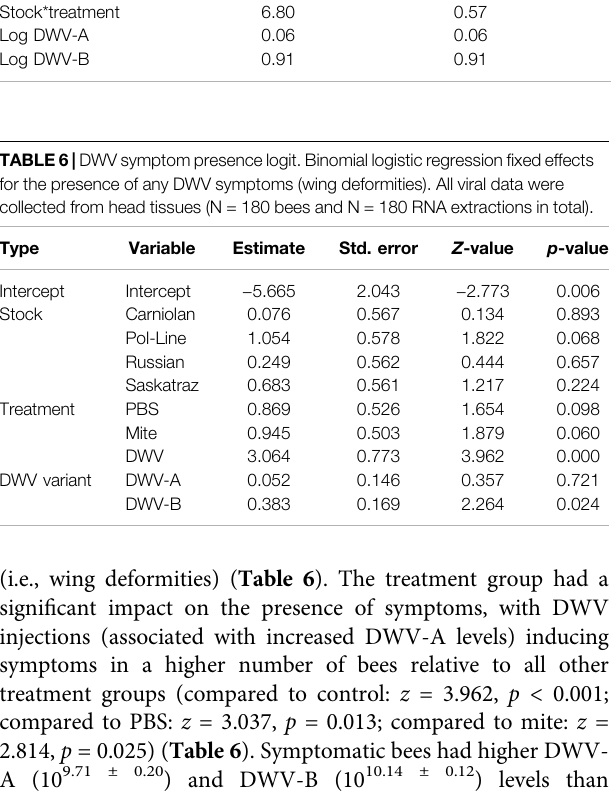
TABLE 5| DaystoemergenceANOVA. ANOVA summaryofthegeneralizedlinearmixedmodel fi xedeffectsforthenumberofdaysuntiladultemergence.Allviraldatawere collected from head tissues (N = 180 bees and N = 180 RNA extractions in total). Supplementary Table S1 for model parameter estimates. Variable SumSq